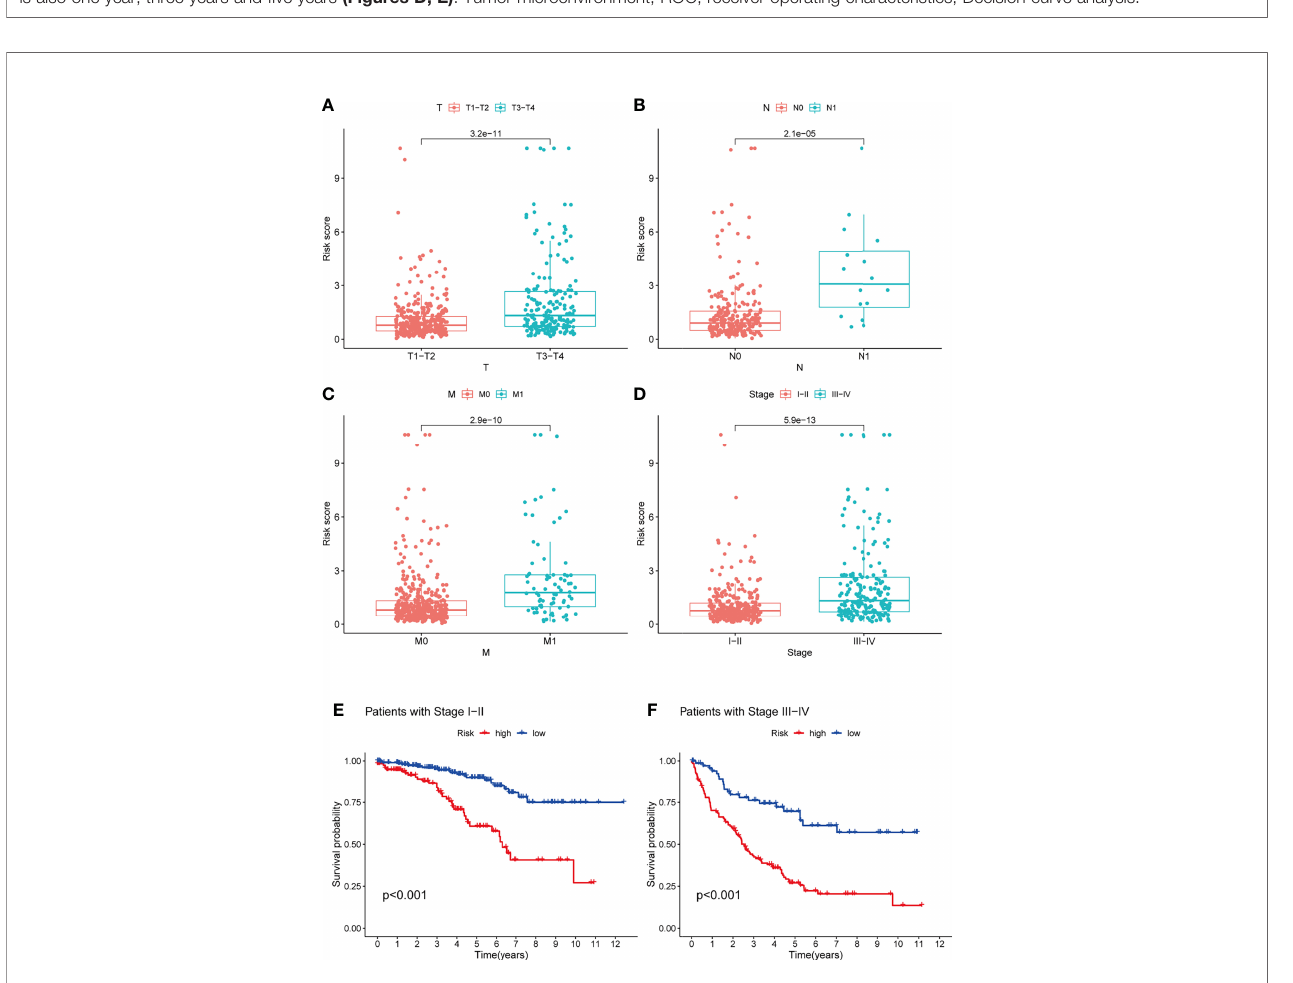
FIGURE 6 | Analysis of the TME-related signature strati fi ed by TNM staging and Stage staging. (A – D) Risk scores also tend to be higher in KIRC patients with combined T3-4, N1, M1, Stage III-IV (P < 0.05). (E, F) Patients with low-risk scores all had a better prognosis in the StageI-II and Stage III-IV groups (P < 0.05). TME, tumor microenvironment; KIRC, Kidney renal clear cell